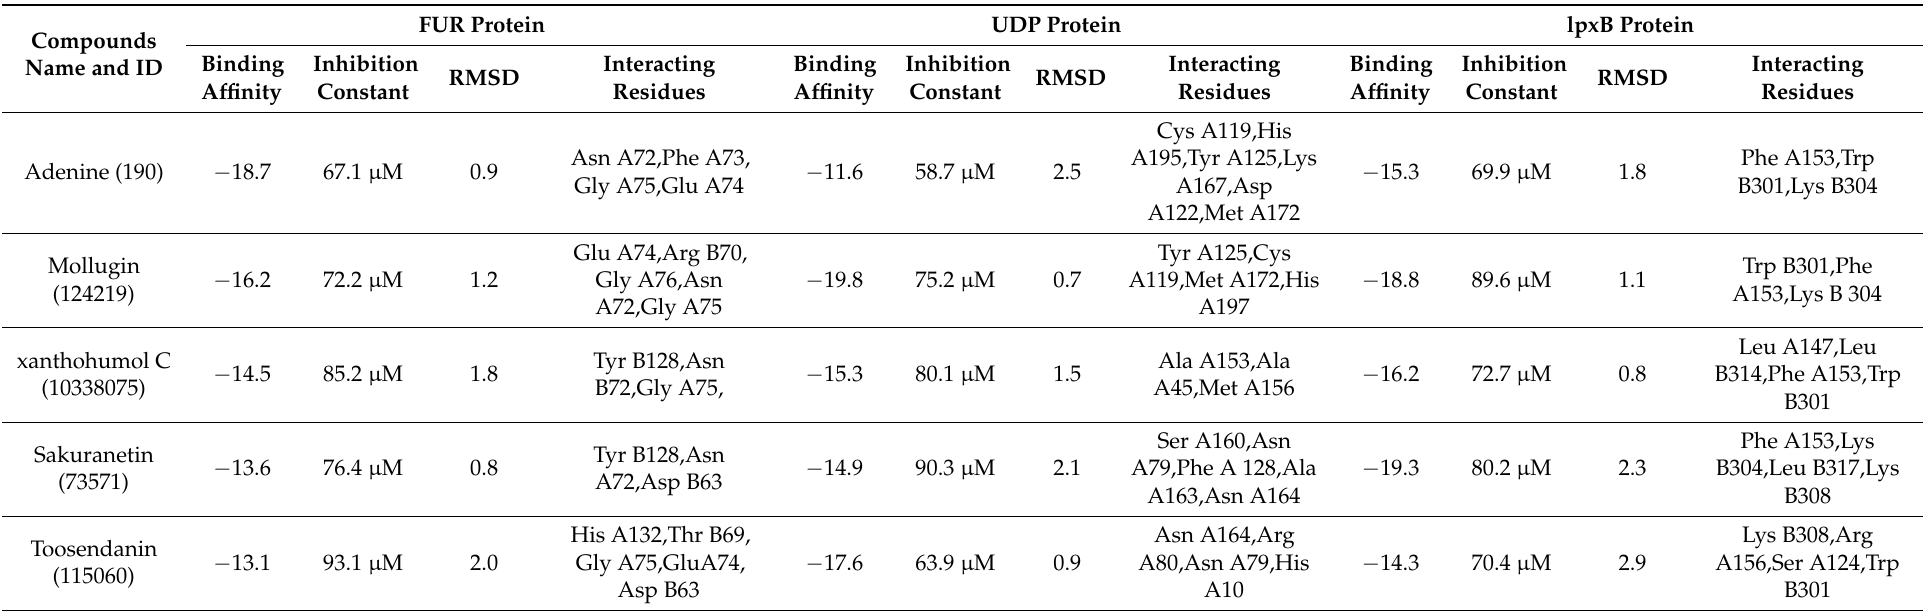
Table 3. Docking statistics of target proteins against plant